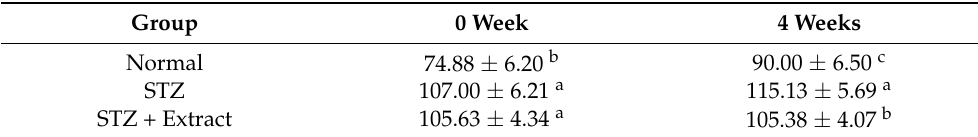
Table 5. The changes of fasting blood glucose (mg/dL) in mice for feeding RF-dried bitter gourd extract. Group 0 Week 4 Weeks Normal 74.88 ± 6.20 b 90.00 ± 6.50 c STZ 107.00 ± 6.21 a 115.13 ± 5.69 a STZ + Extract 105.63 ± 4.34 a 105.38 ± 4.07